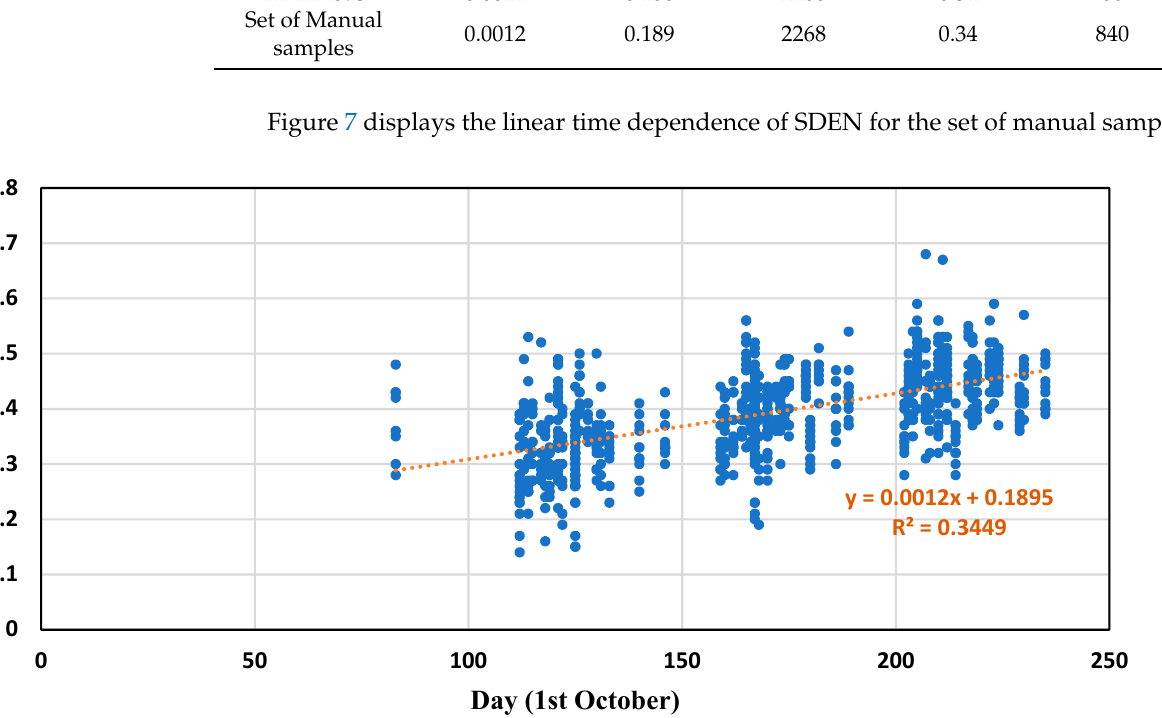
Figure 7. SDEN time dependence for on-site manual sampling. Trend line for the set of manual samples.